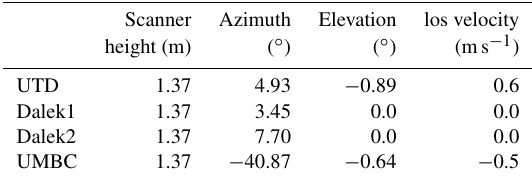
Table 6. Bias errors used for the triple-Doppler data